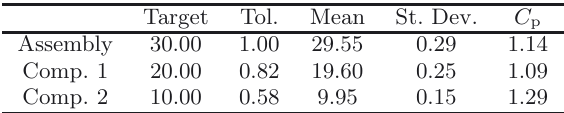
Table 2. Specifications and process characteristics [mm].